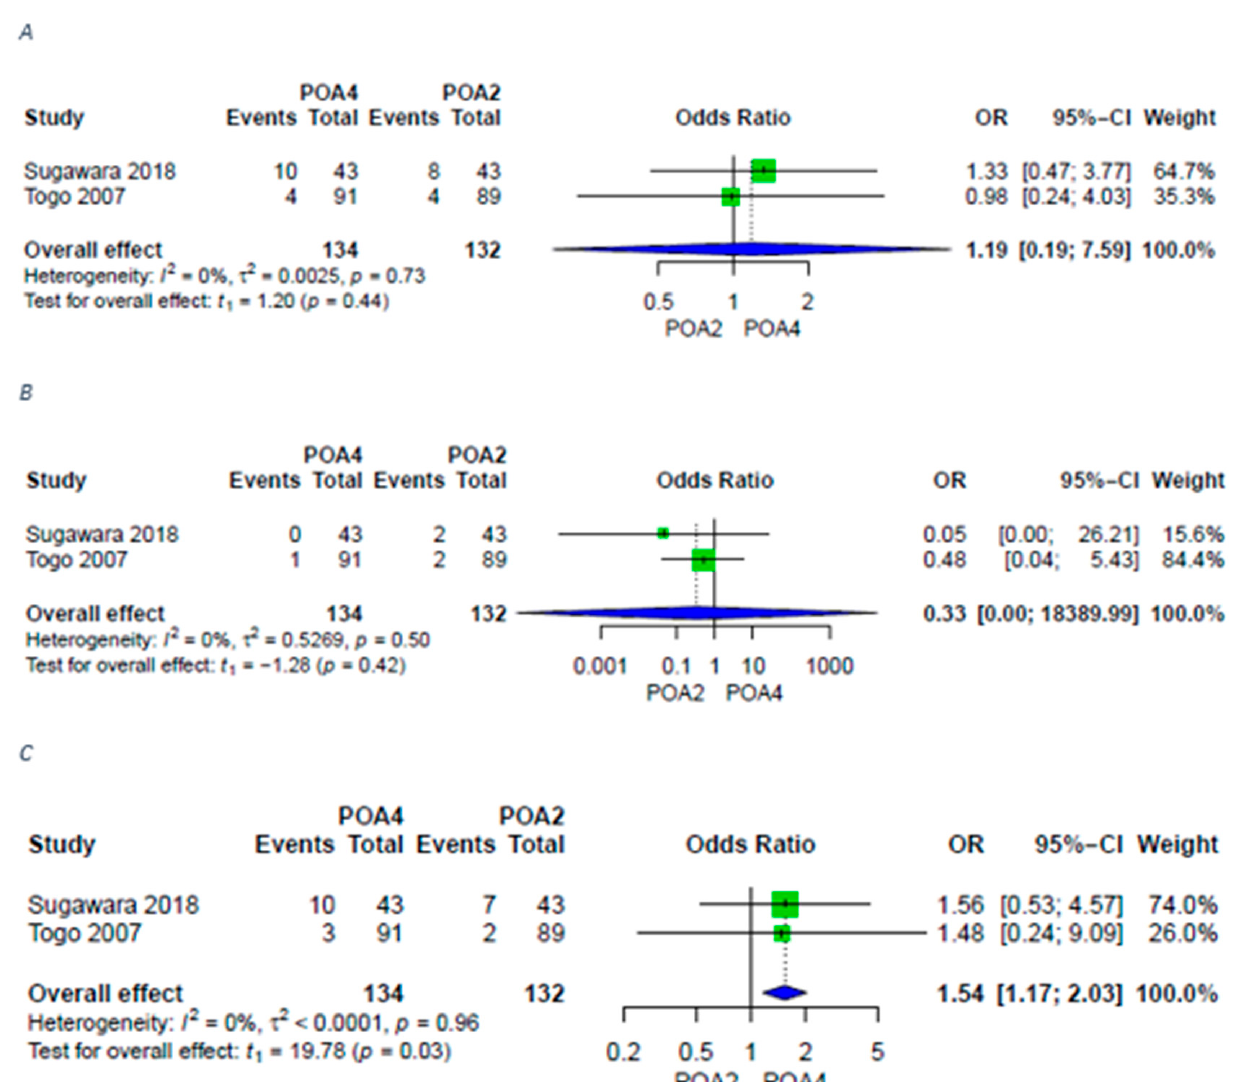
Figure 4. Forest plots for surgical site infections in patients with POA2 versus POA4. ( A ) Forest plot for surgical site infections in patients with POA2 versus POA4; ( B ) Forest plot for superficial surgical site infections in patients with POA2 versus POA4; ( C ) Forest plot for deep surgical site infections in patients with POA2 versus POA4. A random-effects model was utilized for all outcomes due to heterogenic methodological and clinical framework of included studies. Statistical heterogeneity was evaluated using the I 2 statistics. An I 2 value below 25% indicated low heterogeneity, while over 75% was considered high.